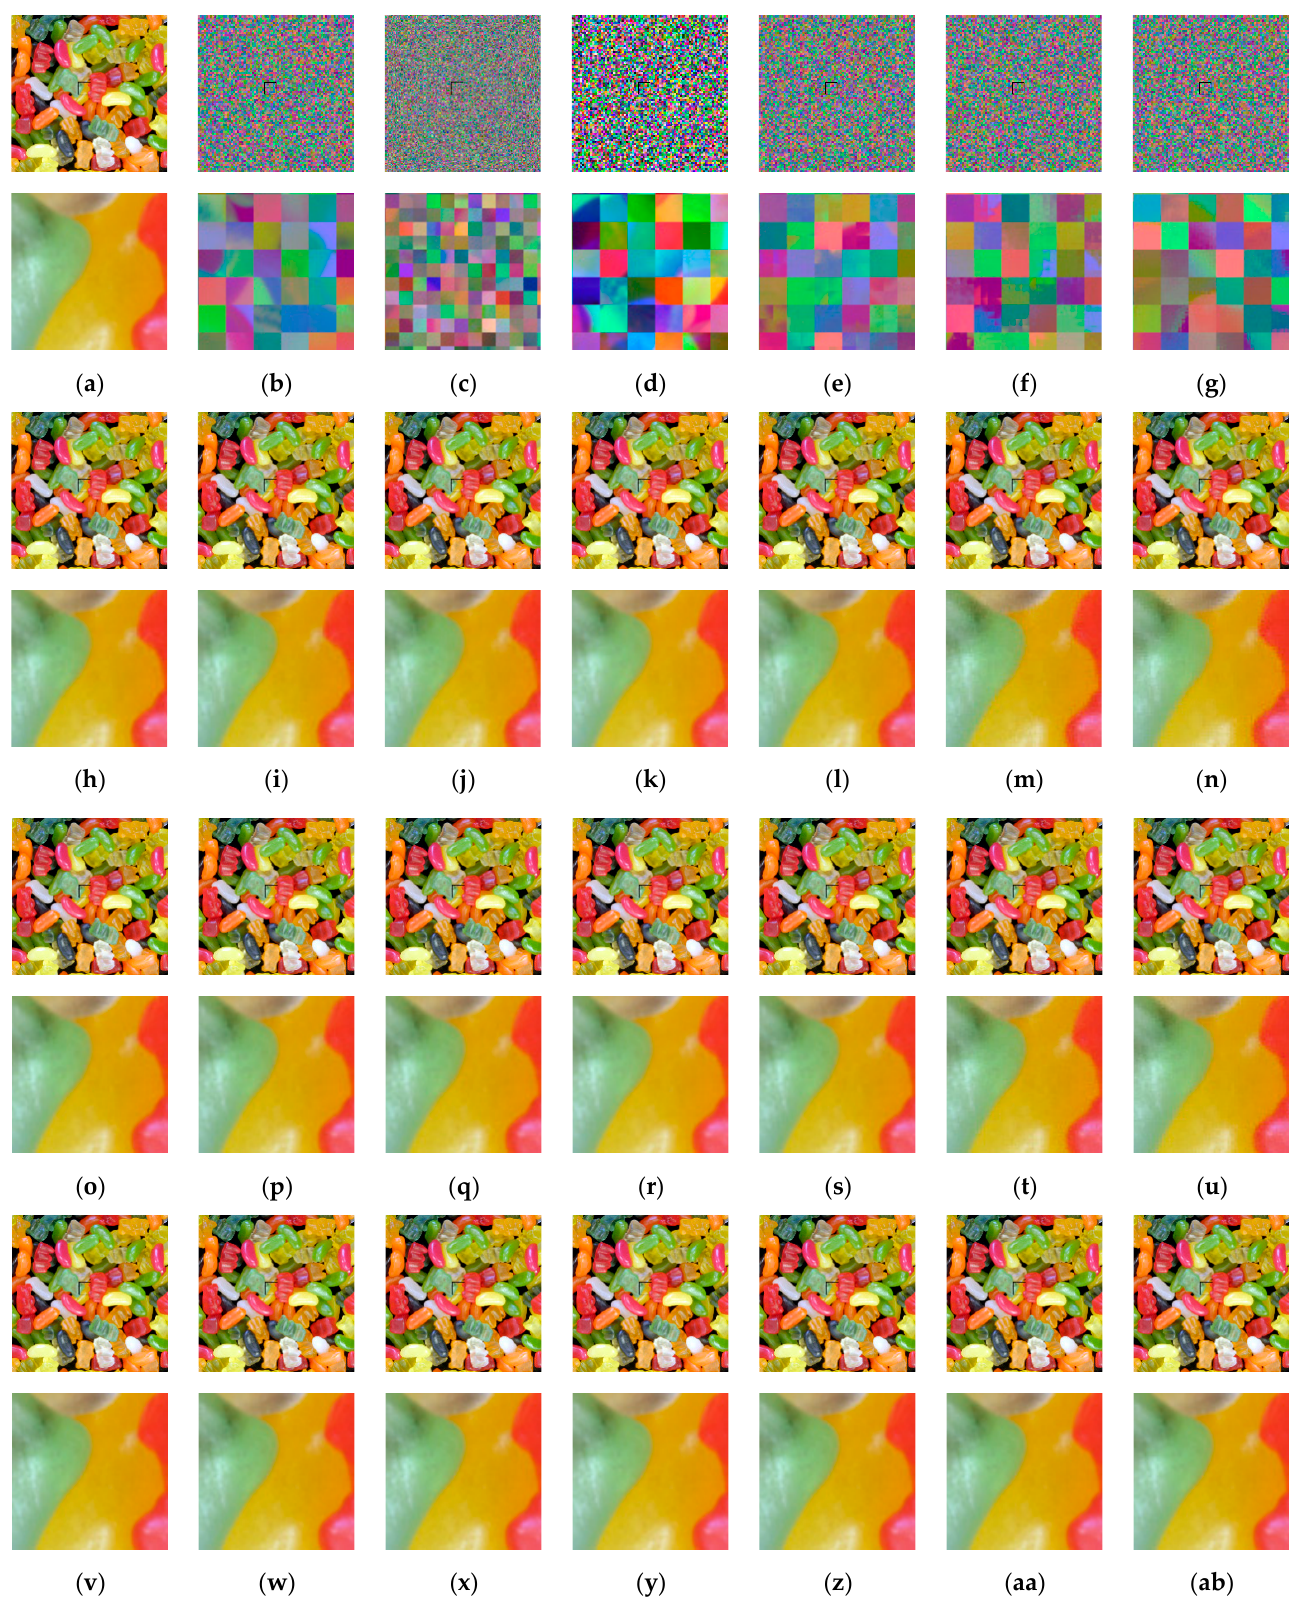
Figure 9. Visual analysis of the images recovered from the CPE processing. The JPEG algorithm was implemented without chroma subsampling. ( a ) The original image. ( b – g ) Cipher images obtained from the Color CPE, PGS–CPE, Extended CPE, IIB–CPE (8 × 8), IIB–CPE (4 × 4), and IIB–CPE (2 × 2) methods, respectively. The images recovered were compressed with the JPEG 𝑞𝑓 = 71 in ( h –